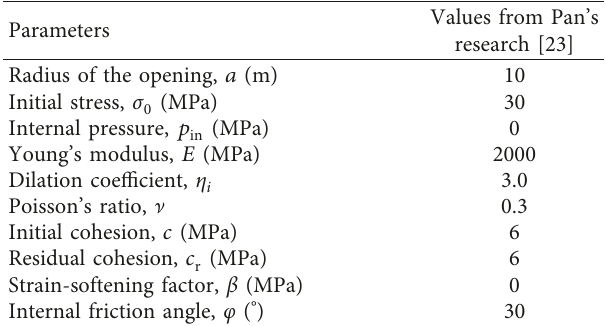
Table 1: Geometrical and physical parameters of the circular